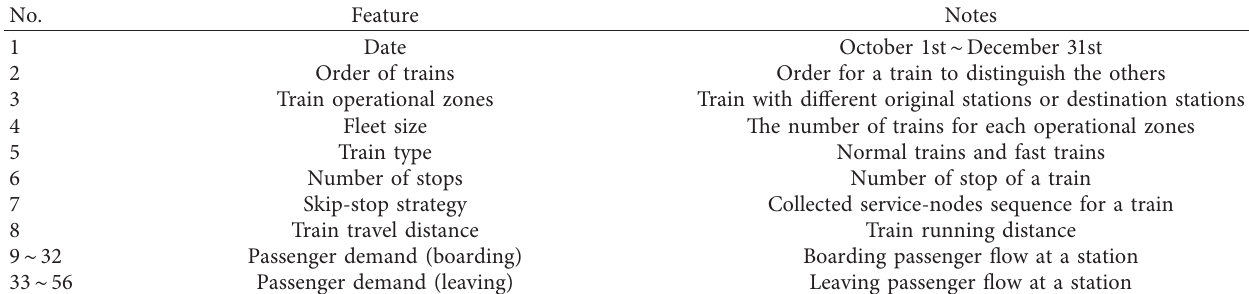
Table 1: Extracted features of operation data.